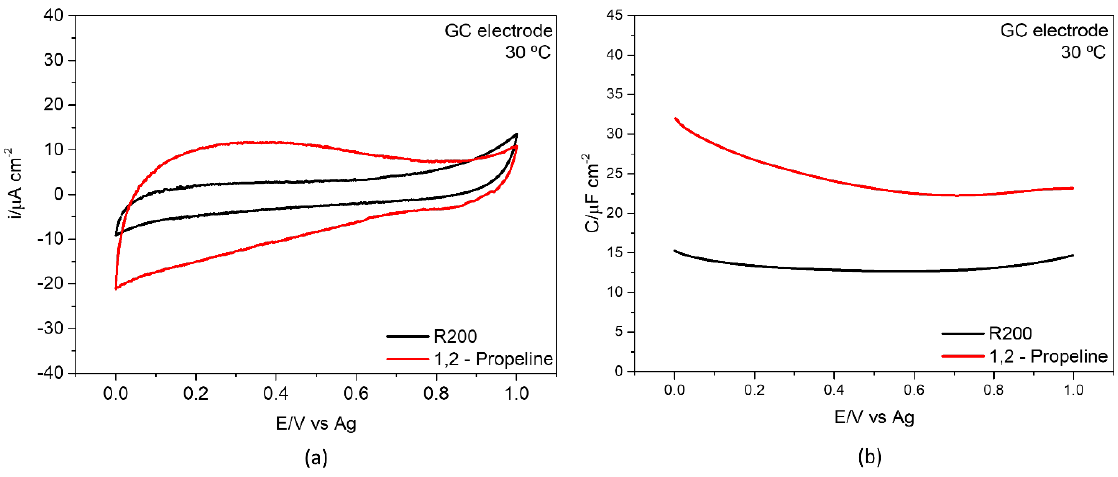
Table 3. Surface area, pore volume and average pore size of commercial graphene and graphite materials.